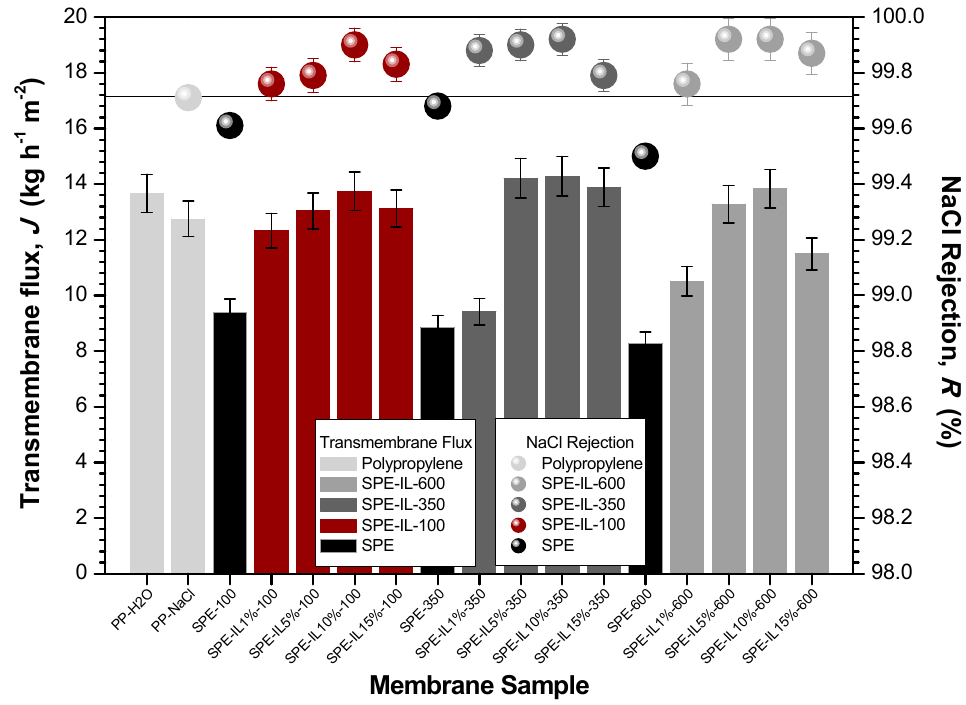
Figure 5. Observed transmembrane fluxes J and NaCl rejections R for tested membranes. Horizontal line is a guide for readers and refers to the rejection of NaCl salt of unfunctionalized PP support.